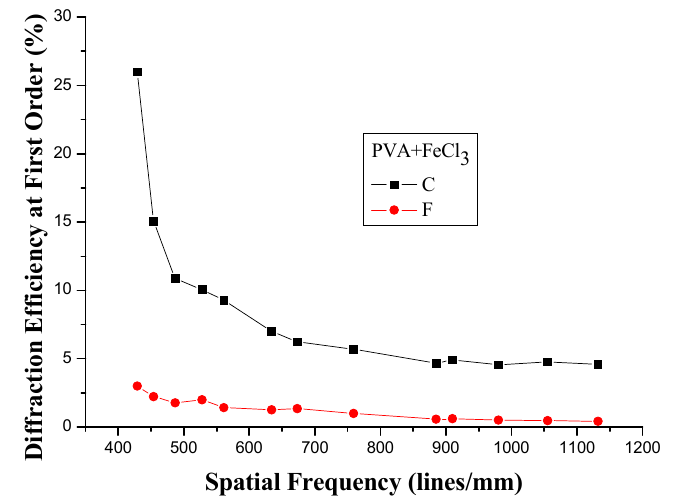
Figure 6. Diffraction efficiency for samples C and F with different spatial